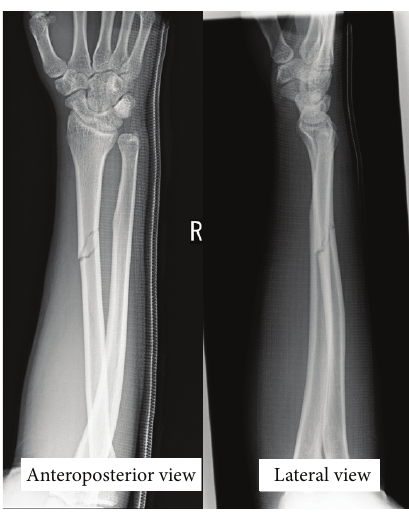
Figure 1: Radiograph of the fractured radius on admission. Figure 2: Short tau inversion recovery magnetic resonance imaging shows significant deviation of the median nerve toward the fracture site of the radius (arrow).